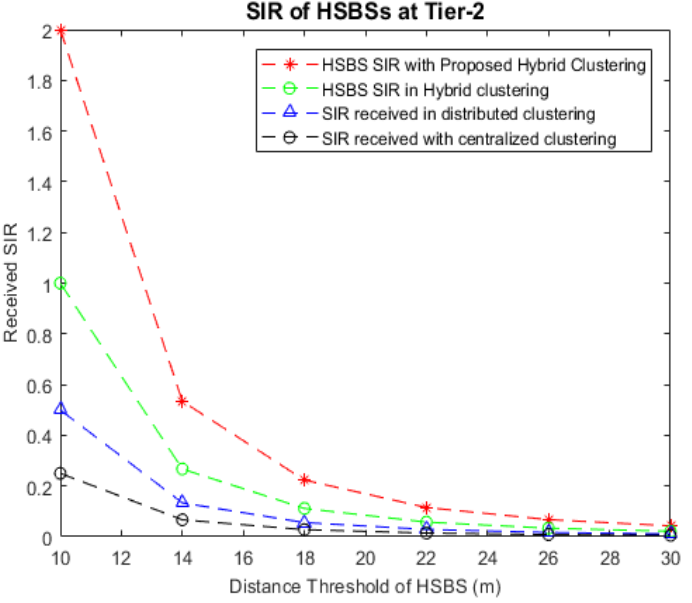
Figure 7. Comparison of received SIR vs. distance in meters at LSBSs with centralized clustering, distributed clustering, existing hybrid clustering, and the IMHC hybrid clustering scheme.